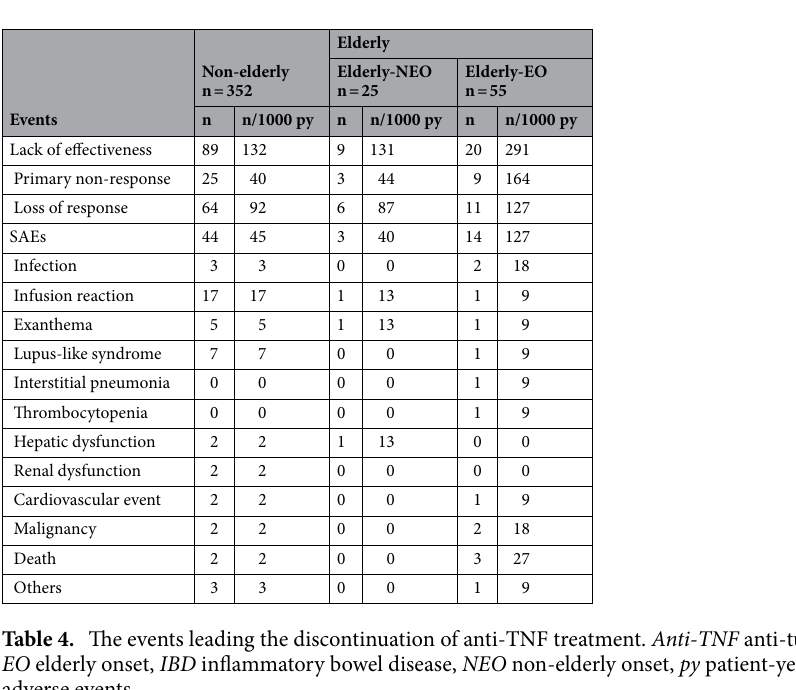
Figure 2. Cumulative events rate leading the discontinuation of anti-TNF treatment. ( a ) Cumulative discontinuation rate in Elderly-EO, Elderly-NEO, and Non-elderly. ( b ) Cumulative SAE rate during first anti- TNF treatment in Elderly-EO, Elderly-NEO, and Non-elderly. Anti-TNF anti-tumor necrosis factor, EO elderly onset, IBD inflammatory bowel disease, NEO non-elderly onset, SAE serious adverse event.